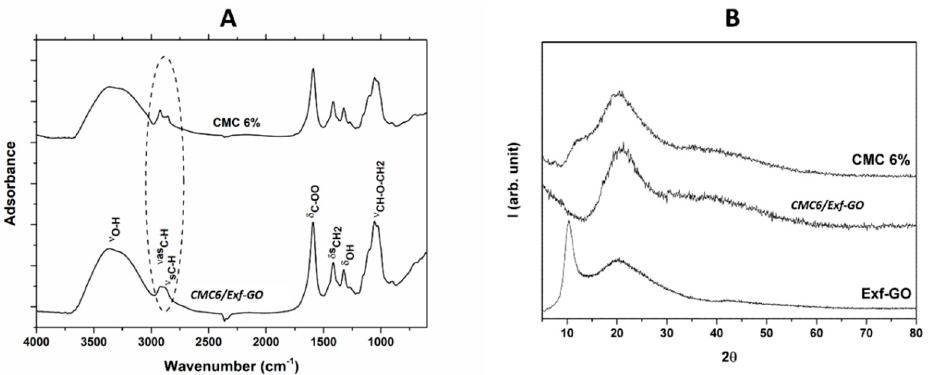
Figure 3. ( A ) IR spectra of CMC6 / Exf -GO nanocomposites and CMC 6% film; ( B ) XRD patterns of Exf -GO, CMC6 / Exf -GO and CMC 6% film.